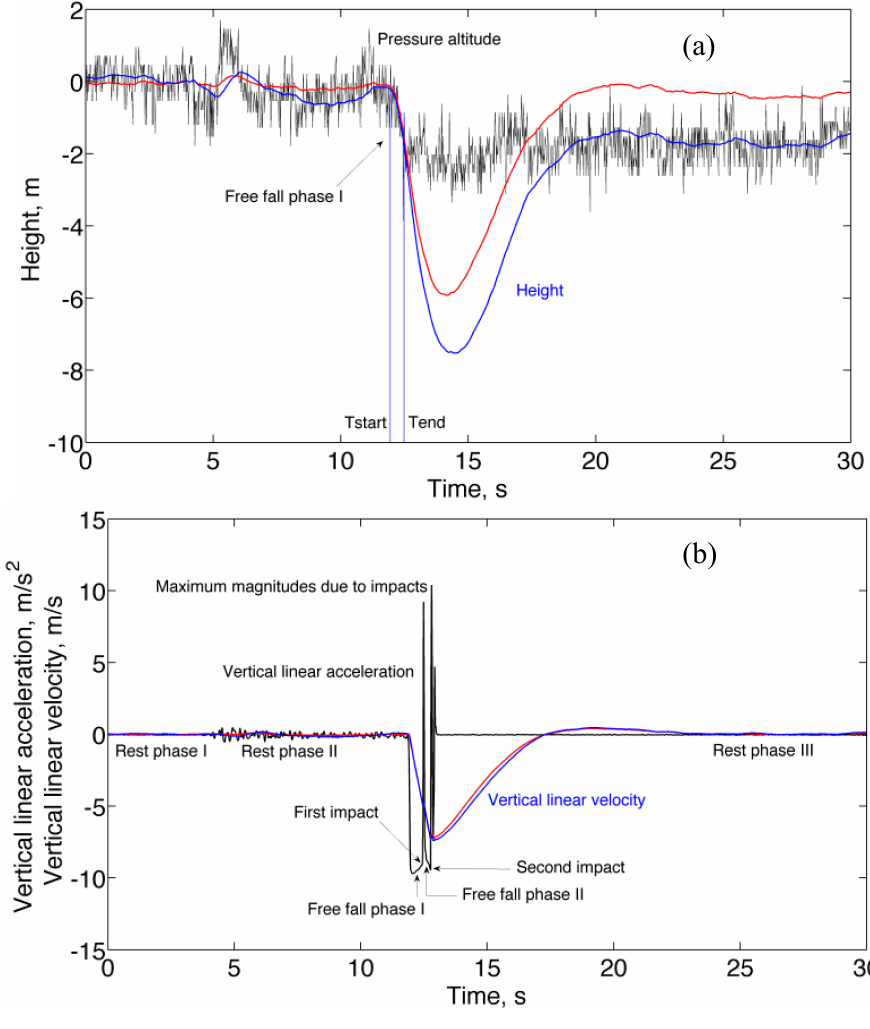
Figure 4. Free-fall motion. ( a ) Height estimated by Method A (blue) and Method B (red) with superimposed the raw pressure altitude (black); ( b ) Vertical velocity estimated by Method A (blue) and Method B (red) with superimposed the vertical linear acceleration